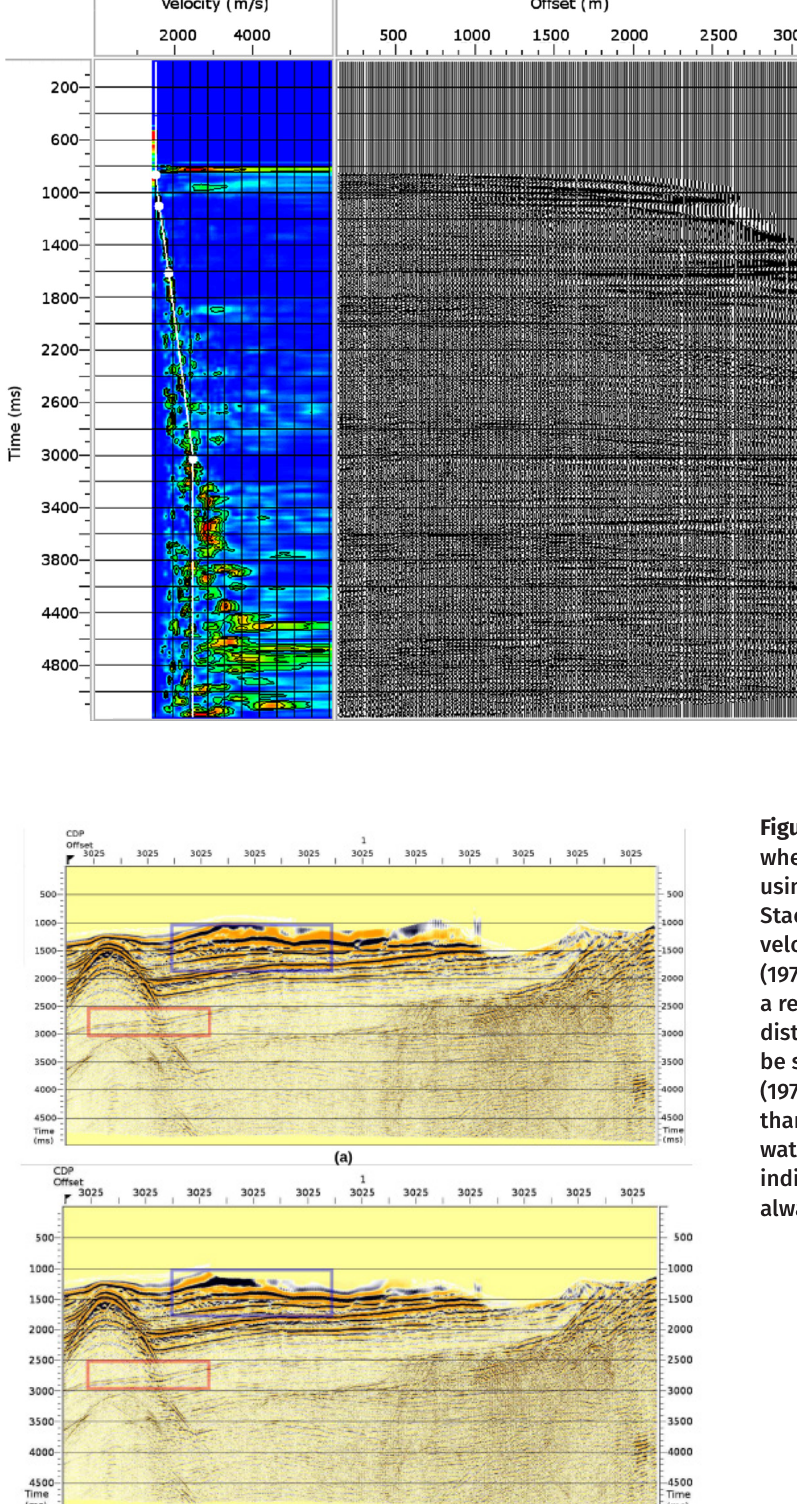
Figure 8. Velocity spectrum (left) and respective NMO correction (right) for the CMP gather 977. Estimated velocities (points on the white curve) were obtained through the non-hyperbolic approximation of Al-Chalabi (1973).